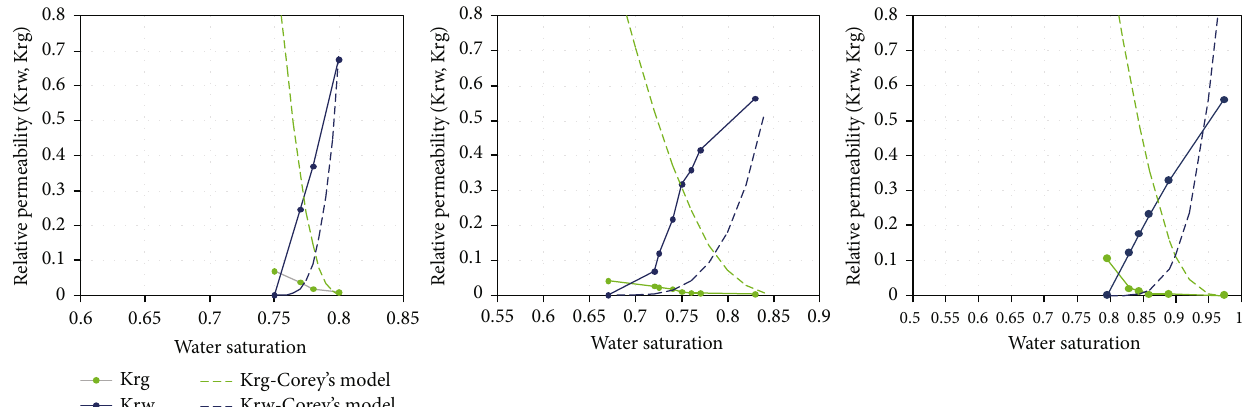
Figure 5: The comparison between experimental results and Corey ’ s empirical formula.